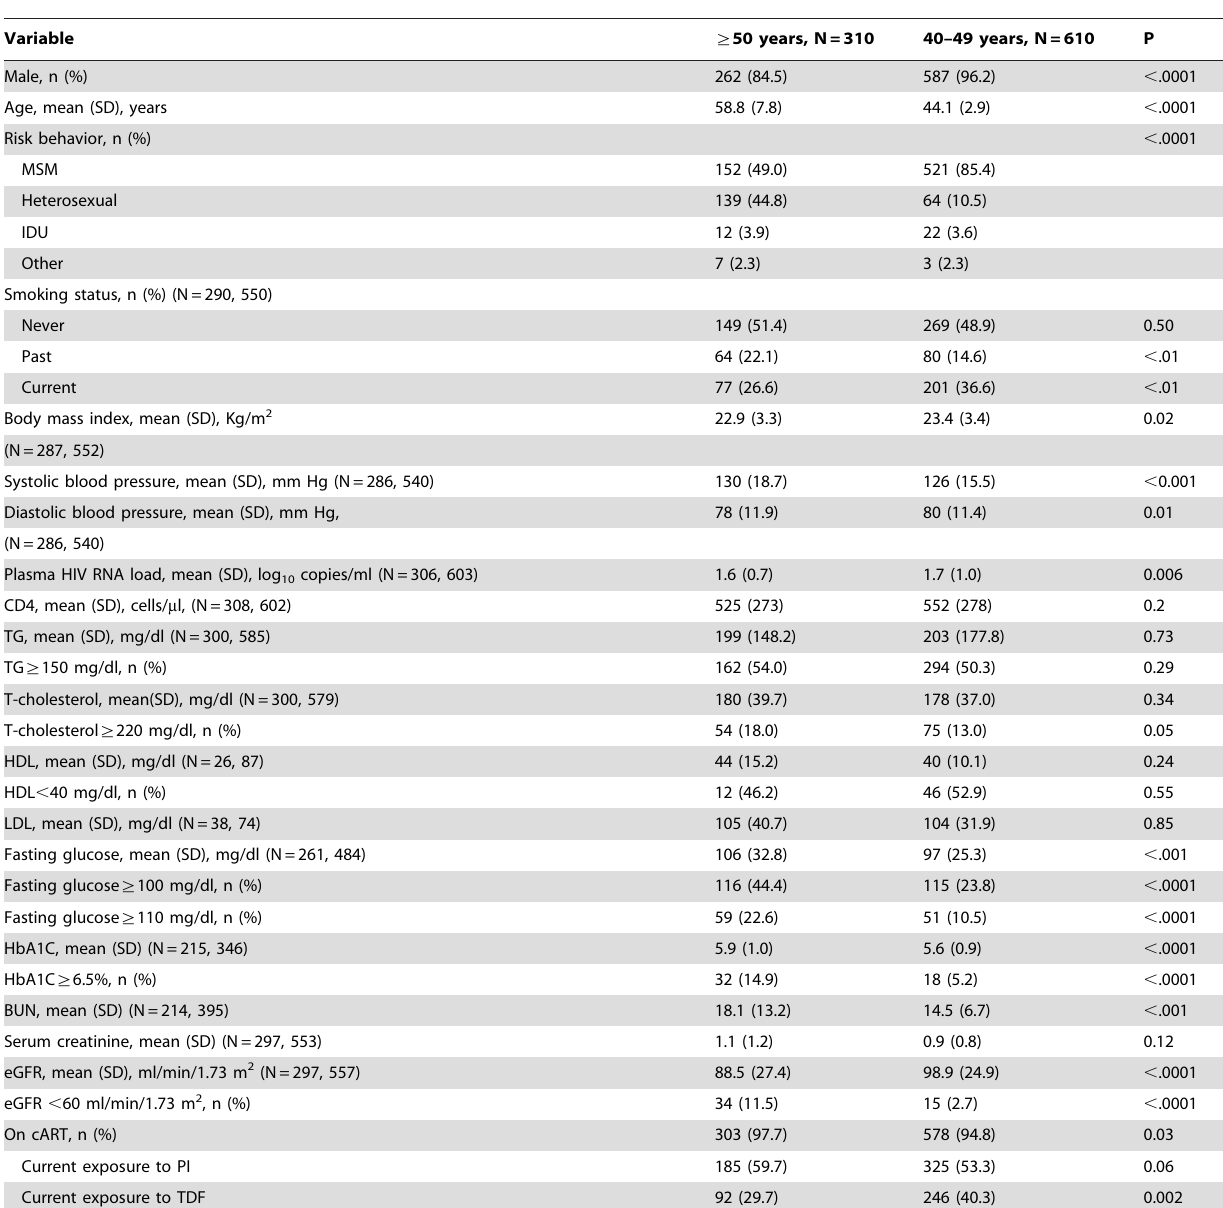
Table 1. Comparisons of demographic and clinical characteristics of the two study populations according to age.